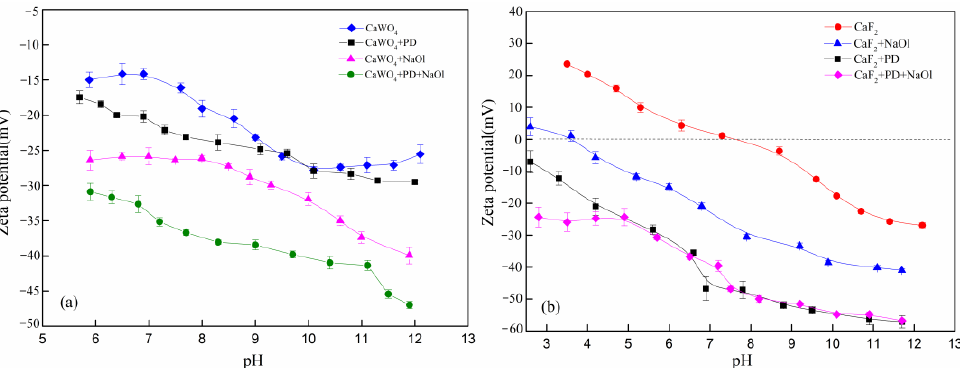
Figure 6. Effects of adding different reagents on the zeta potentials of ( a ) scheelite and ( b ) fluorite (NaOl = 1.5 × 10 −5 mol/L; PD = 1.6 × 10 −4 mol/L).